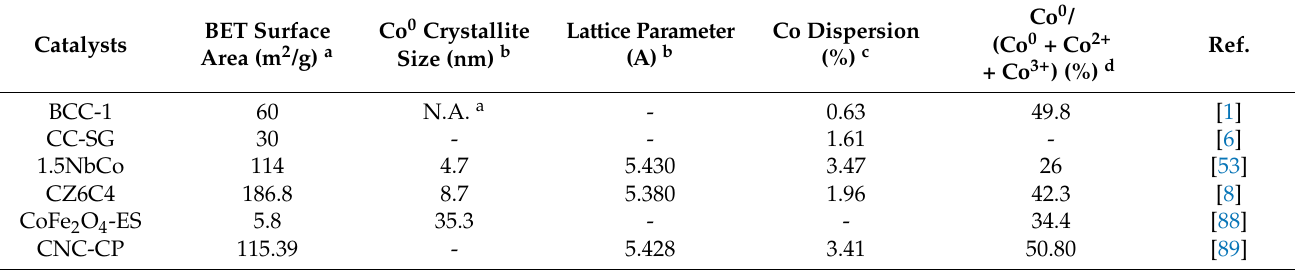
Table 8. Characteristics of Co-based